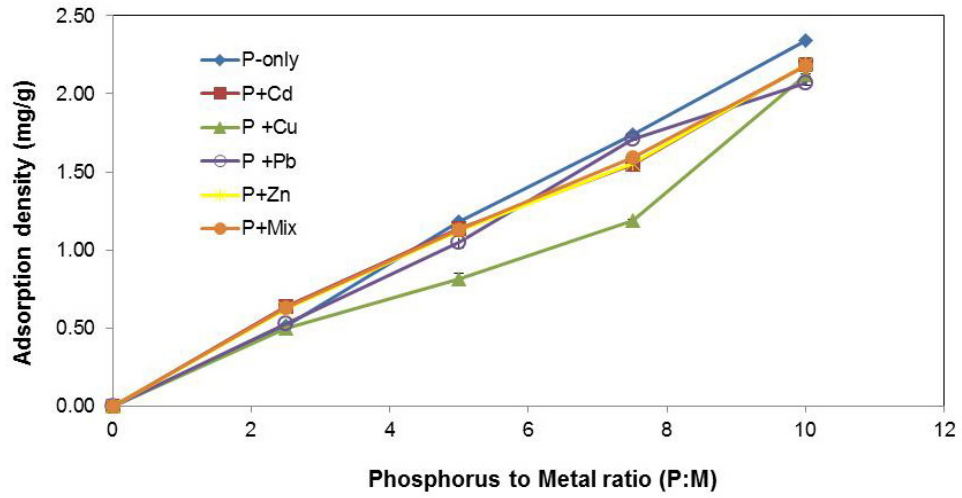
Figure 3. Influence of P